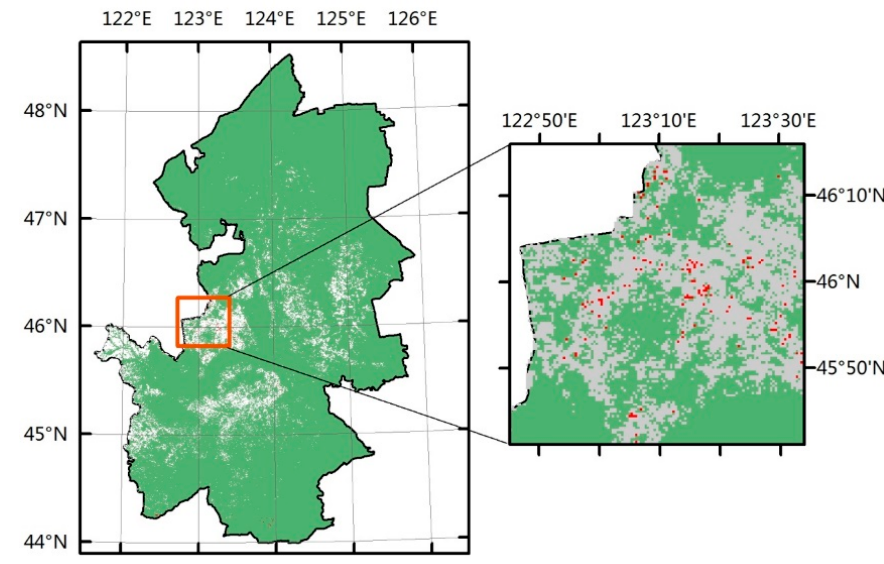
Figure 10. The spatial distribution of significant degradation pixels detected by P-RESTREND but was not detected by RESTREND.